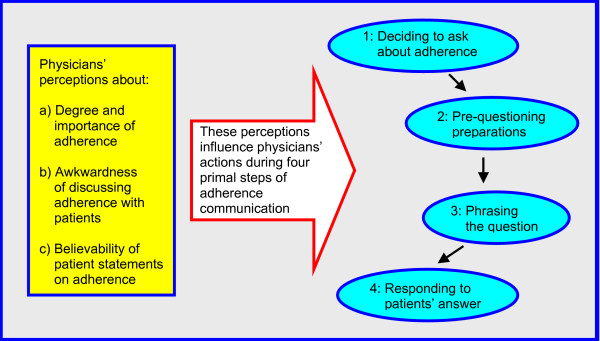
Model of physicians' adherence communication (simple version). Physicians go through four steps when communicating with patients about adherence. The way physicians act in these is markedly influenced by three aspects of their perceptions (see figure 2 for an expanded version of the model).